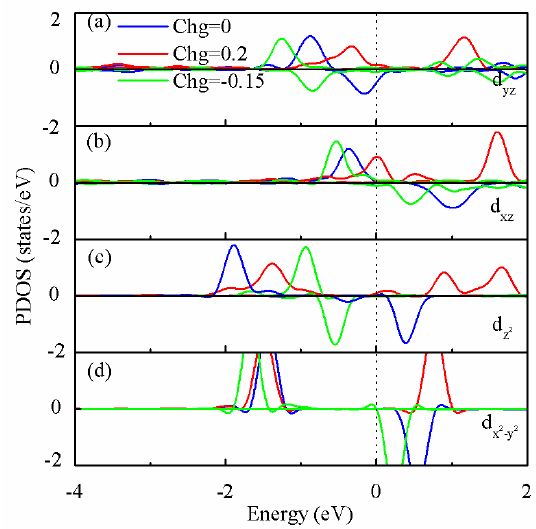
Figure 4. The projected density of states (PDOS) of typical Re - 5d orbitals in Re@NDV under q = − 0.15e, 0e and 0.2e injecting charge per unit cell, respectively. ( a ) d yz orbital, ( b ) d xz orbital, ( c ) d z2 orbital, ( d ) d x2 - y2 orbital.